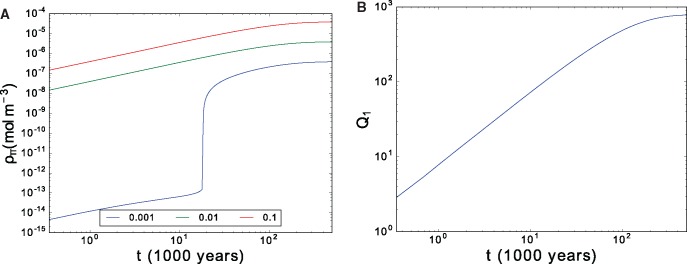
(a) Time evolution of the polymerase for initial concentration ρr=ρp=0.001, 0.01, and 0.1 mol m−3. (b) Q1 for initial concentration ρr=ρr=0.01 molm−3. Parameter values: KP−=4×10−11s−1, Z=106 mol−1 m3 s−1, λ=0.15.